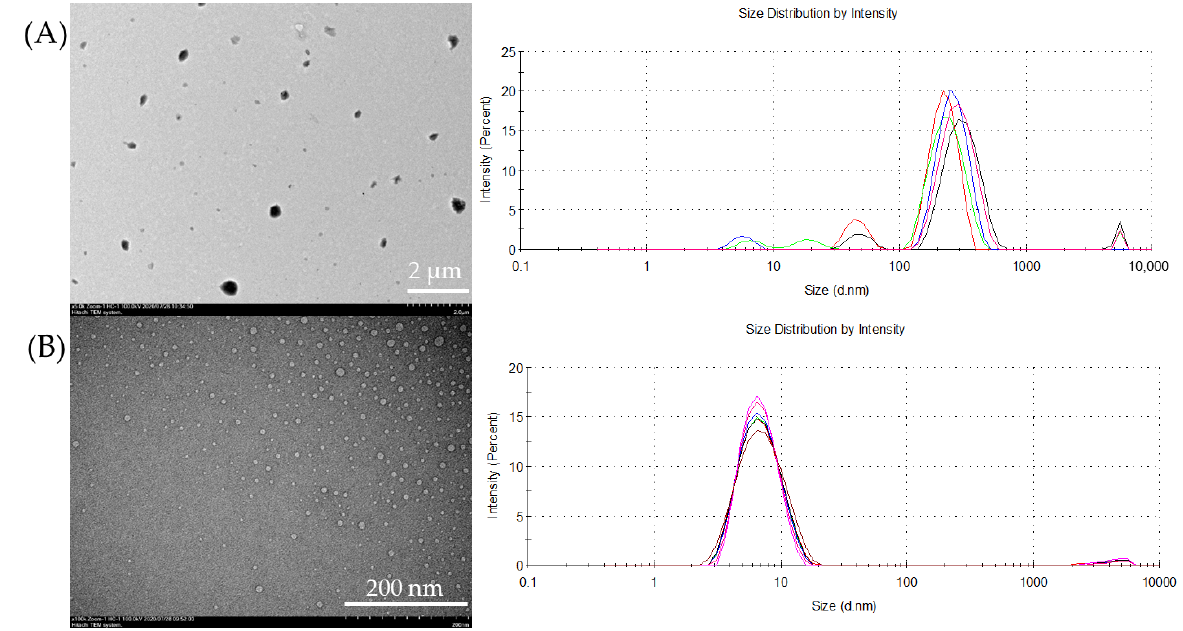
Figure 1. Size analysis of the ( A ) 3 and ( B ) 3 /BSA by TEM ( left ) and DLS ( right ). Colored lines represent multiple experiments.